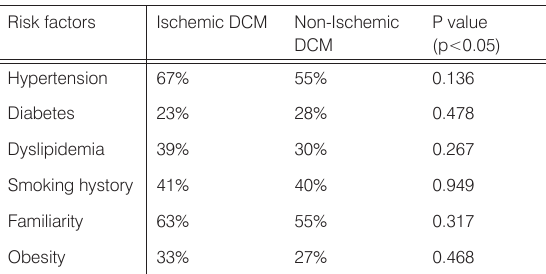
Table 1. The characteristics of the patients enrolled in the study. Dilated Cardomyopathy: DCM. Risk